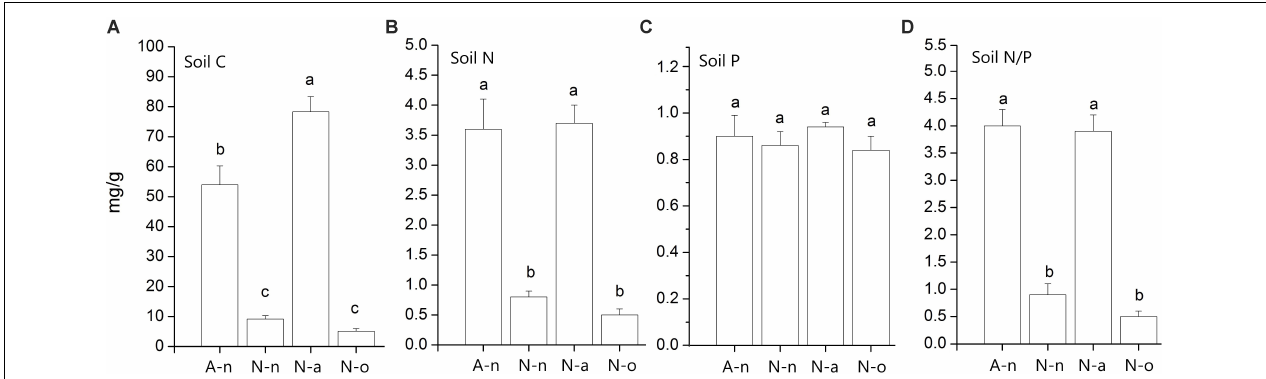
FIGURE 2 | Mean ( ± 1 SE; n = 4) values of soil C content (A) , soil N content (B) , soil P content (C) and soil N/P ratio (D) in the four treatments. Within each panel different letters represent significant ( P < 0.05) differences.